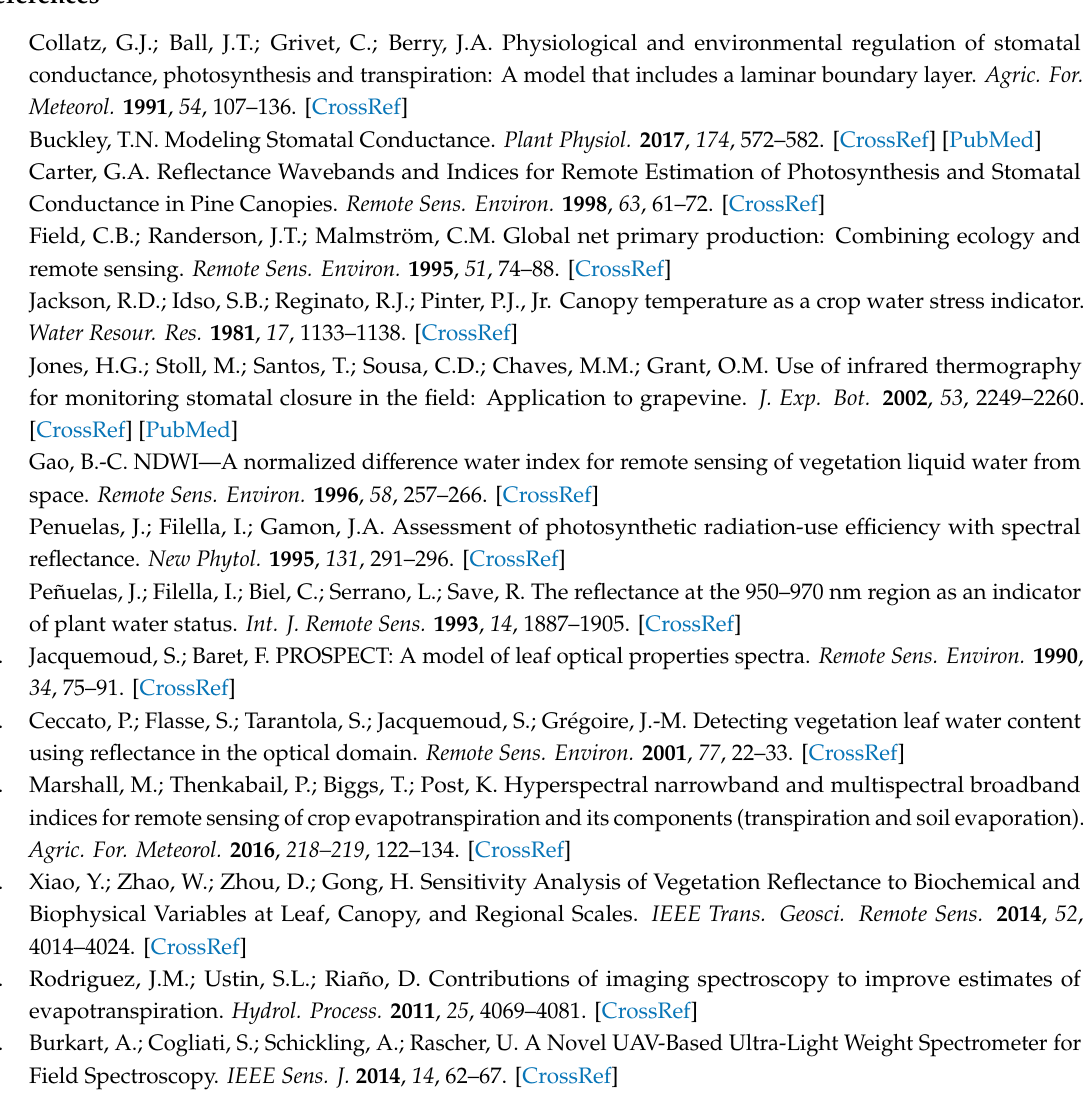
Figure S1: Multiple Linear Regression (MLR) partial correlations between each of the 24 wavelengths selected by the Random Forest algorithm and measured stomatal conductance., Figure S2: Representations of visual cluster analysis within the scores plot of the Partial Least Squares Regression algorithm during model construction on of stomatal index of a cotton